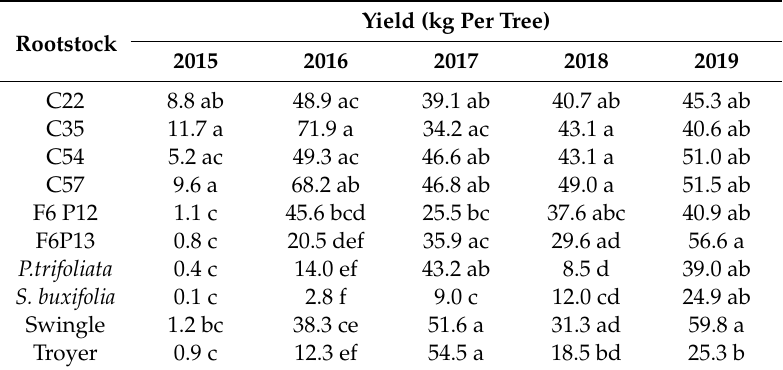
Table 2. Yield of Mandared grafted onto 10 rootstocks calculated from 2015 to 2019. Different letters indicate significantly different means according to Tukey’s test at p < 0.05.